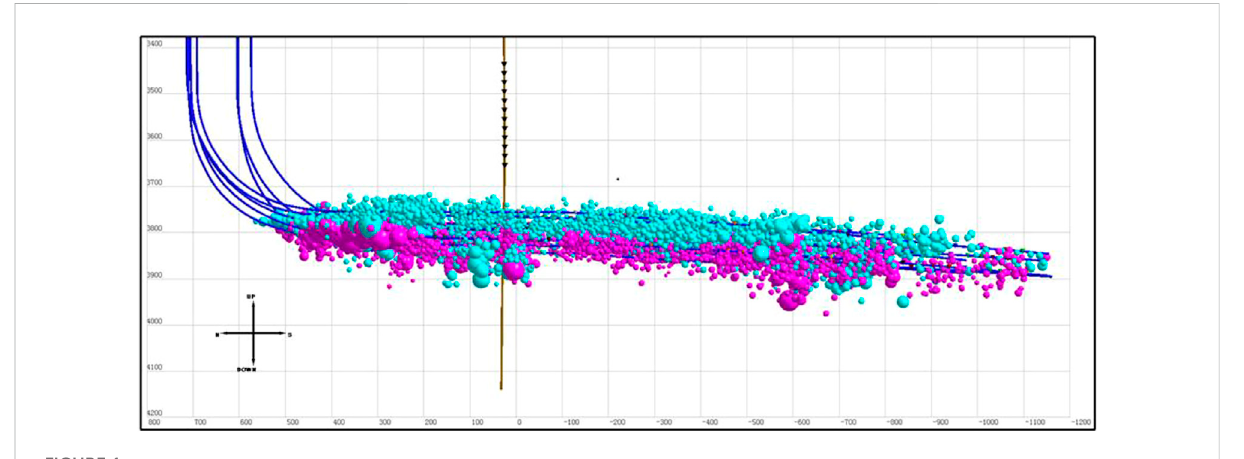
FIGURE 1 Microseismic monitoring map of well